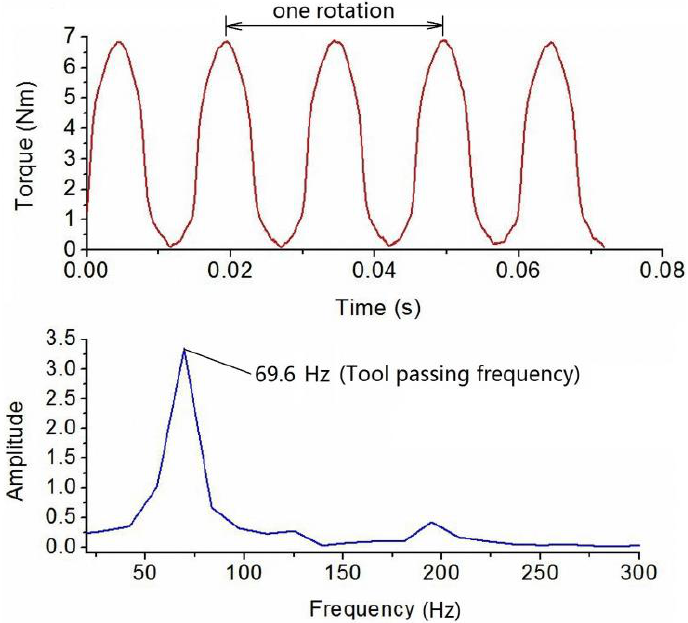
Figure 14. Plots of torque force signals in time and frequency domain at a spindle speed of 2000 rpm.